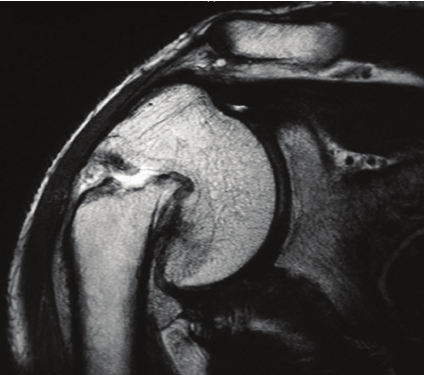
Figure 4: Preoperative T2-weighted MR image shows neither the rotator cuff tear nor the fluid collection in the subacromial